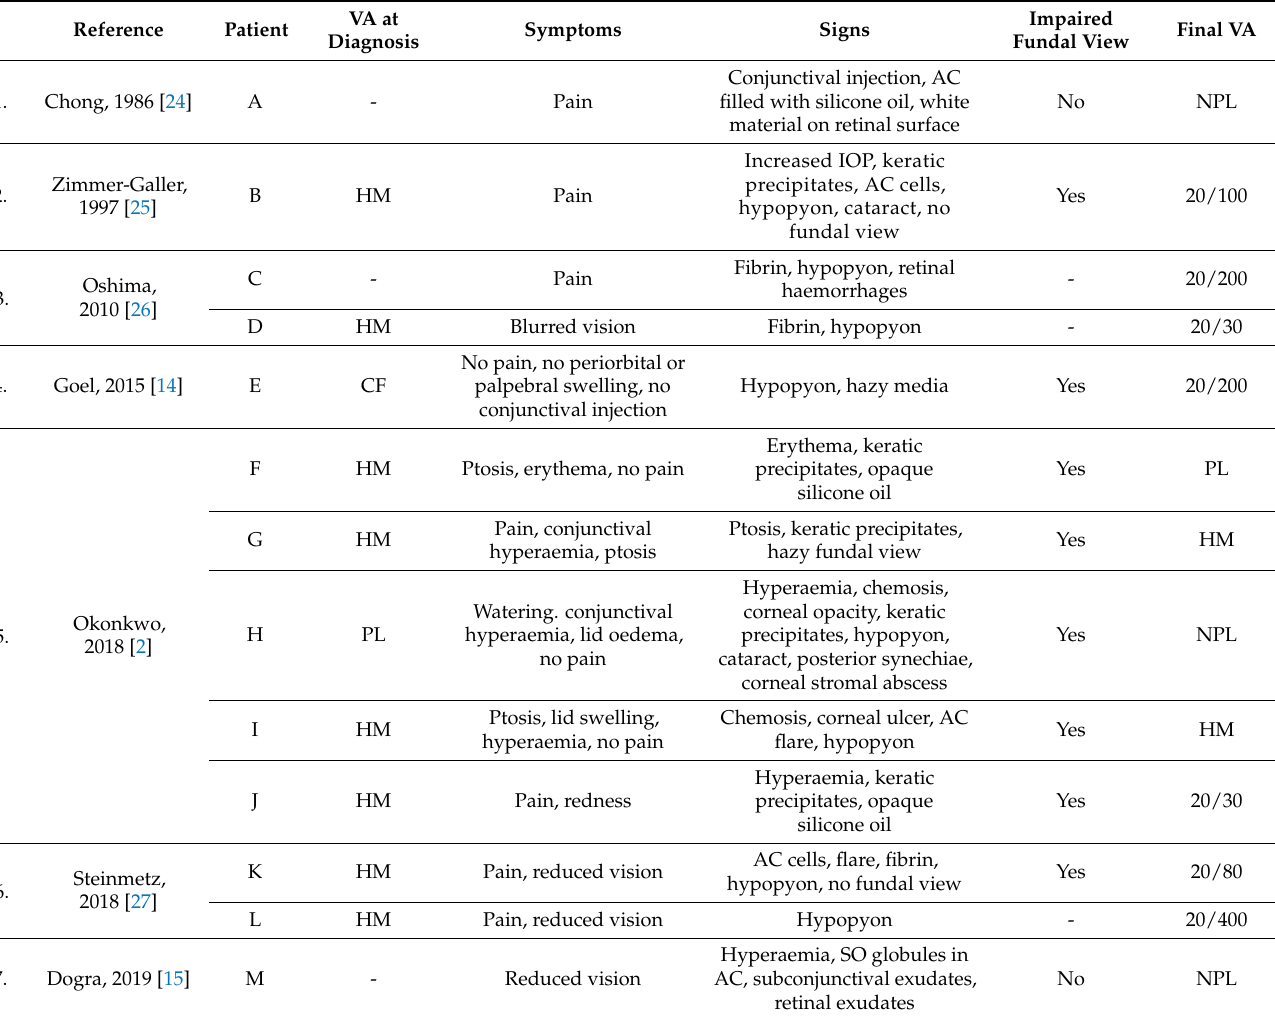
Table 2. Summary of clinical features from previous reports of endophthalmitis in silicone oil- filled